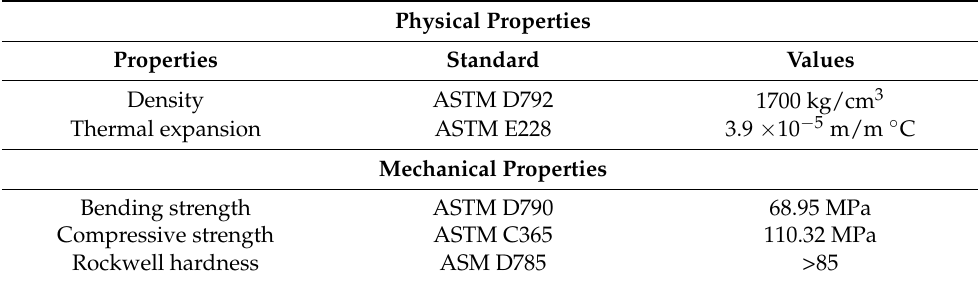
Table 2. Mechanical and physical properties as provided by the artificial stone manufacturer.